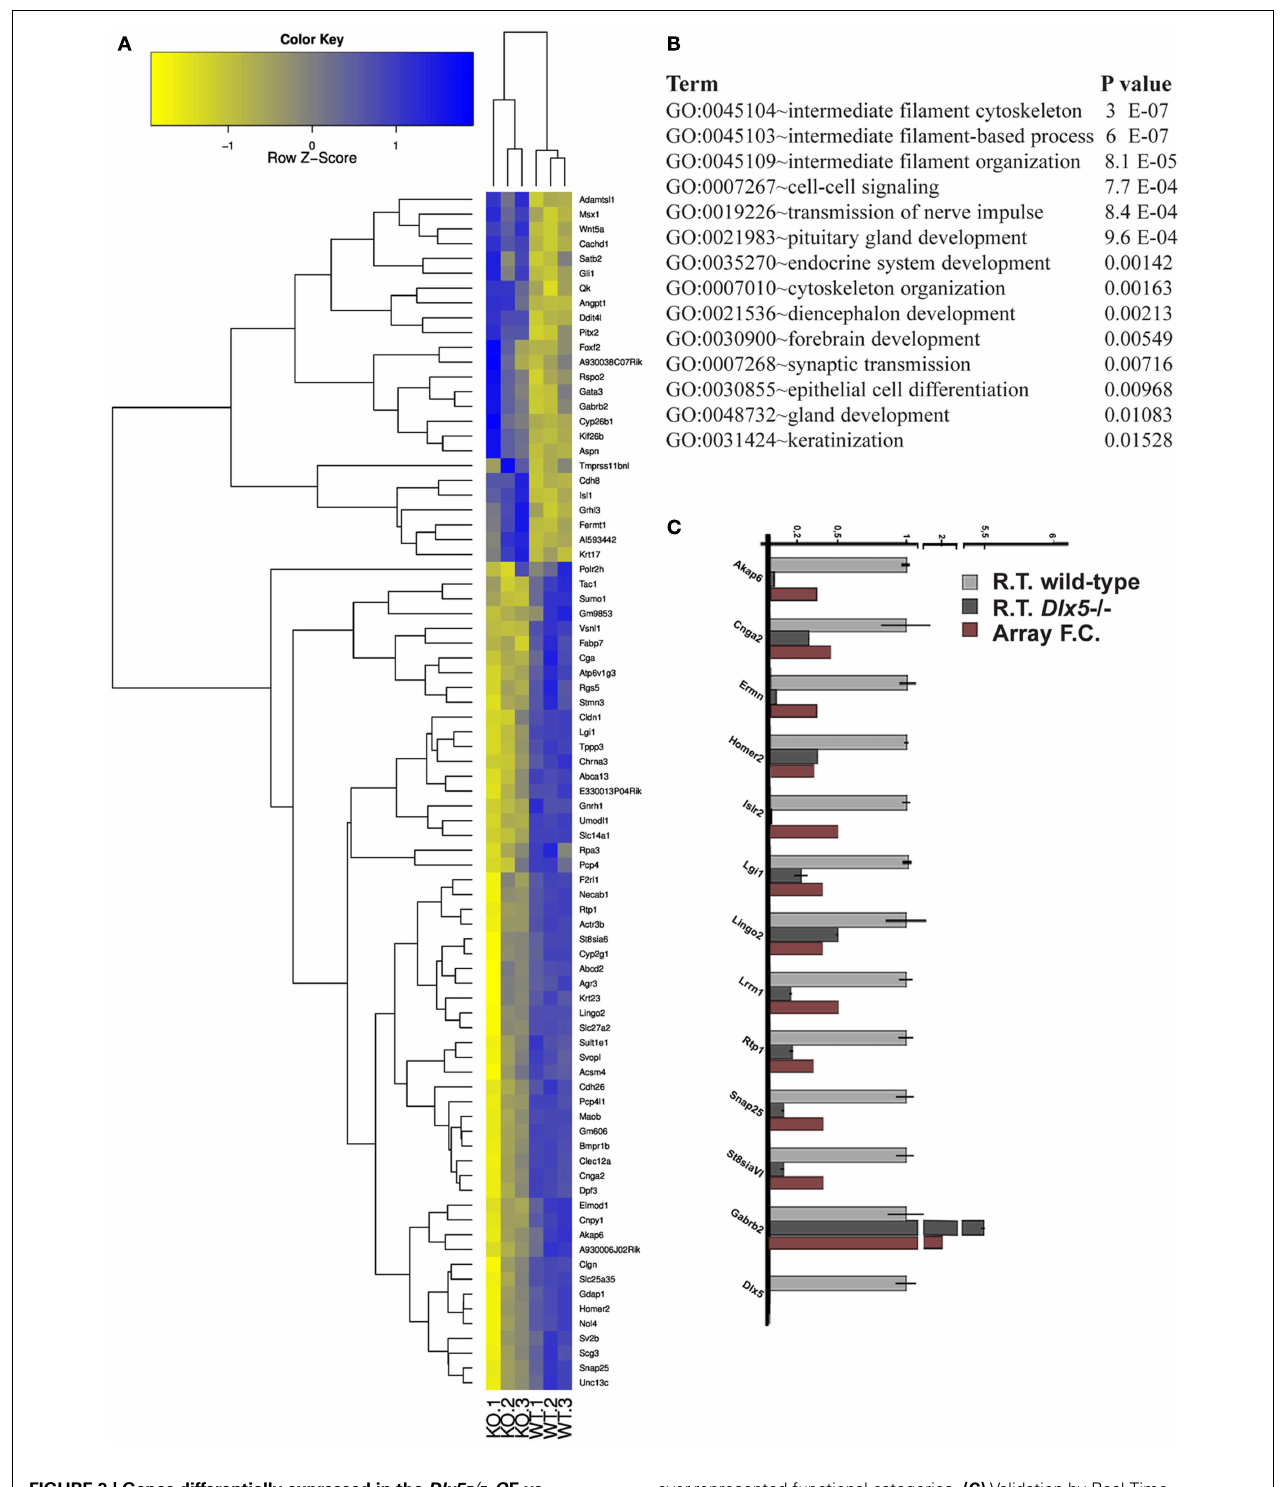
FIGURE 3 | Genes differentially expressed in the Dlx5 − / − O E vs. wild-type OE . (A) Heatmap and cluster analyses on the MicroArray data, after elimination of non-annotated genes and of the OR genes.The triplicate Dlx5 − / − (KO) and wild-type (WT) samples are indicated at the bottom. (B) Gene Ontology to detect